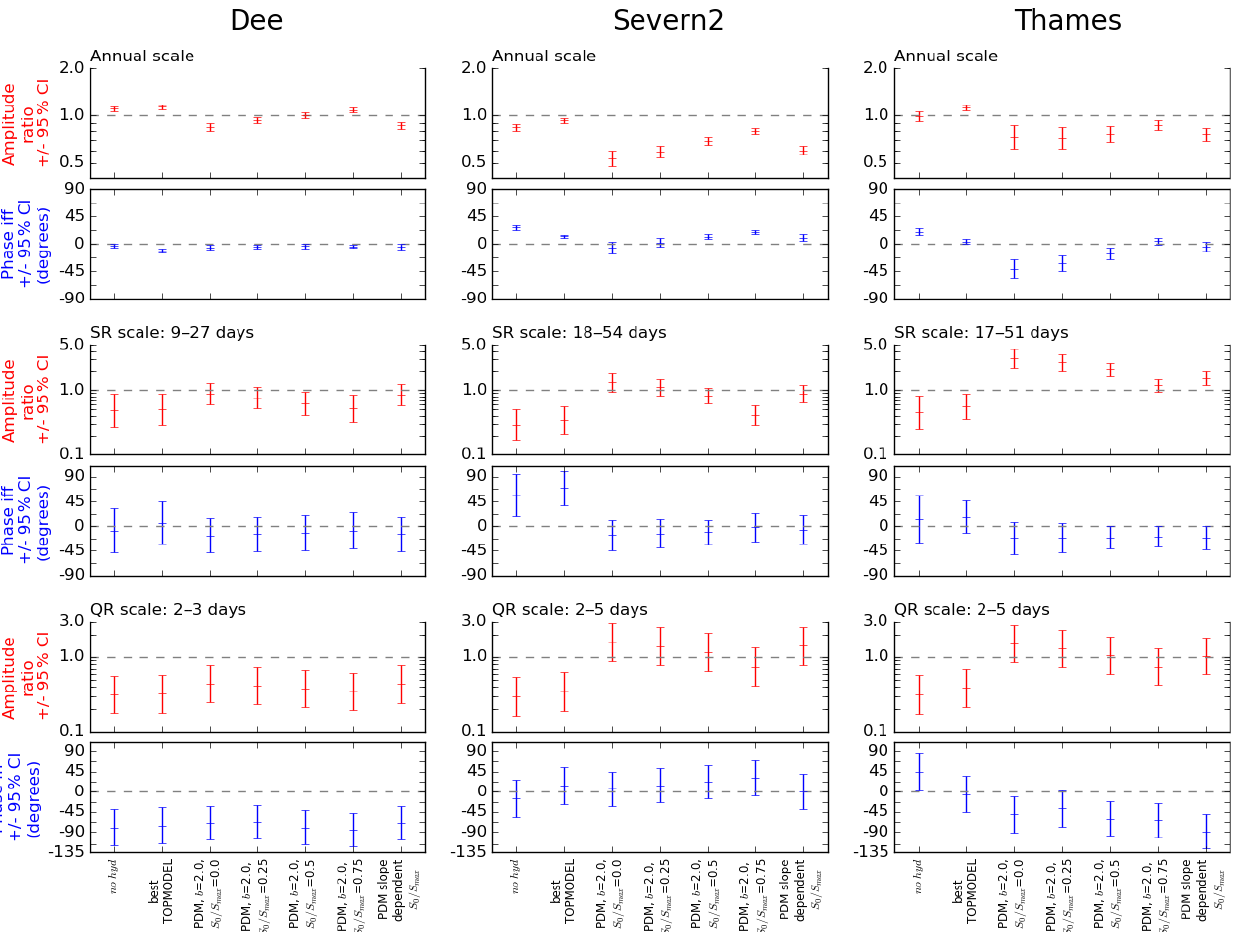
Figure 11. Cross-spectral analysis of river flow from JULES using a range of parameterisations from the tests described in Sect. 2.2.2, for three catchments: Dee (left), Severn2 (middle) and Thames (right). From left to right on the x axis of every plot: no hyd (as in Figs. 8–9), best TOPMODEL (as in Figs. 8–9), PDM with b = 2 . 0 and S 0 /S max = 0 . 0, PDM with b = 2 . 0 and S 0 /S max = 0 . 25, PDM with b = 2 . 0 and S 0 /S max = 0 . 5, PDM with b = 2 . 0 and S 0 /S max = 0 . 75 and PDM with b = 2 . 0 and grid-cell slope-dependent S 0 /S max (as in Figs. 8–9). For each catchment, amplitude ratios (red) and phase differences (blue) are shown on the annual scale (top two rows), SR scale (middle two rows) and QR scale (bottom two